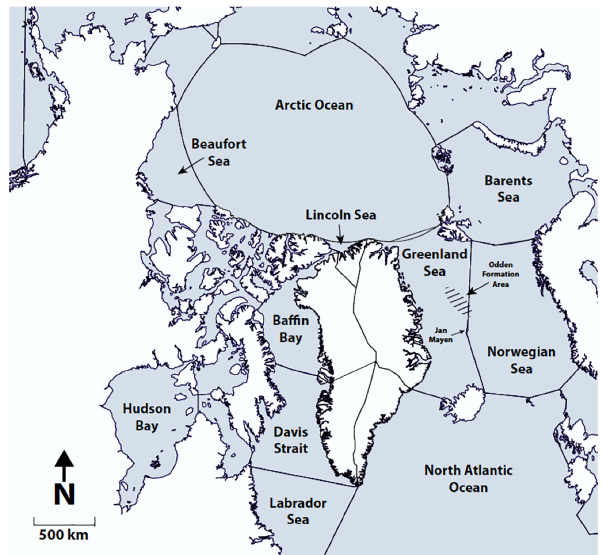
Figure 2. Map of study area, including the six sea ice and Green- land drainage sectors used in this study. The ice sheet regions are named after their adjacent sea (i.e., Davis Strait, Baffin Bay, Lin- coln Sea, Greenland Sea, and the North Atlantic). The approximate area where the Odden sea ice used to form is indicated with hatched lines. The ocean boundaries are defined by the International Hydro- graphic Organization (VLIZ 2005; IHO Sea Areas; available online at